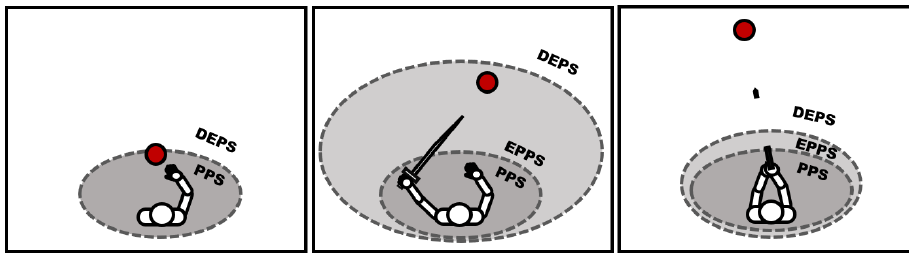
Figure 1. In-game interaction with a target object placed within the peripersonal space (PPS; left ), extended peripersonal space (EPPS; middle ) and distant extrapersonal space (DEPS; right